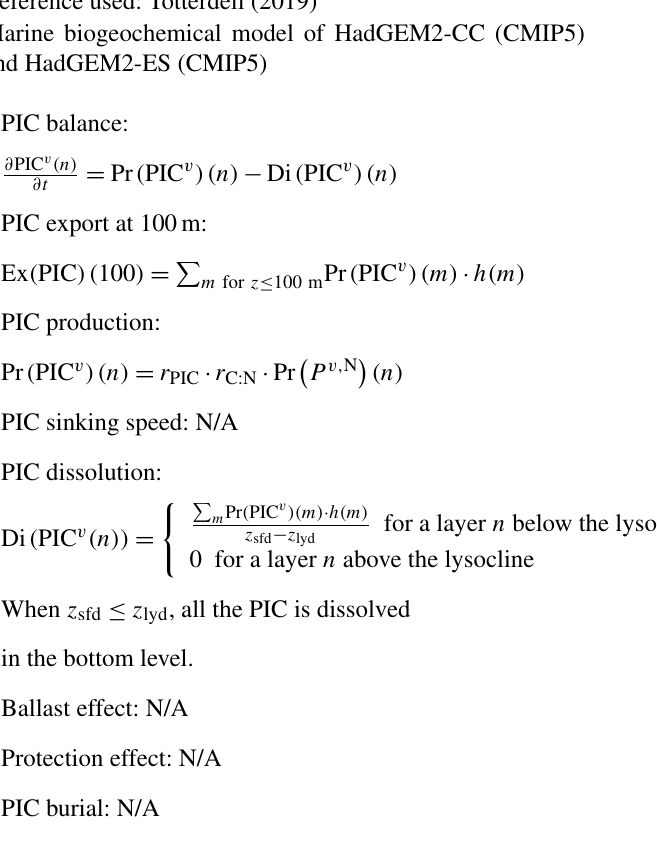
Table C10. Diat-HadOCC